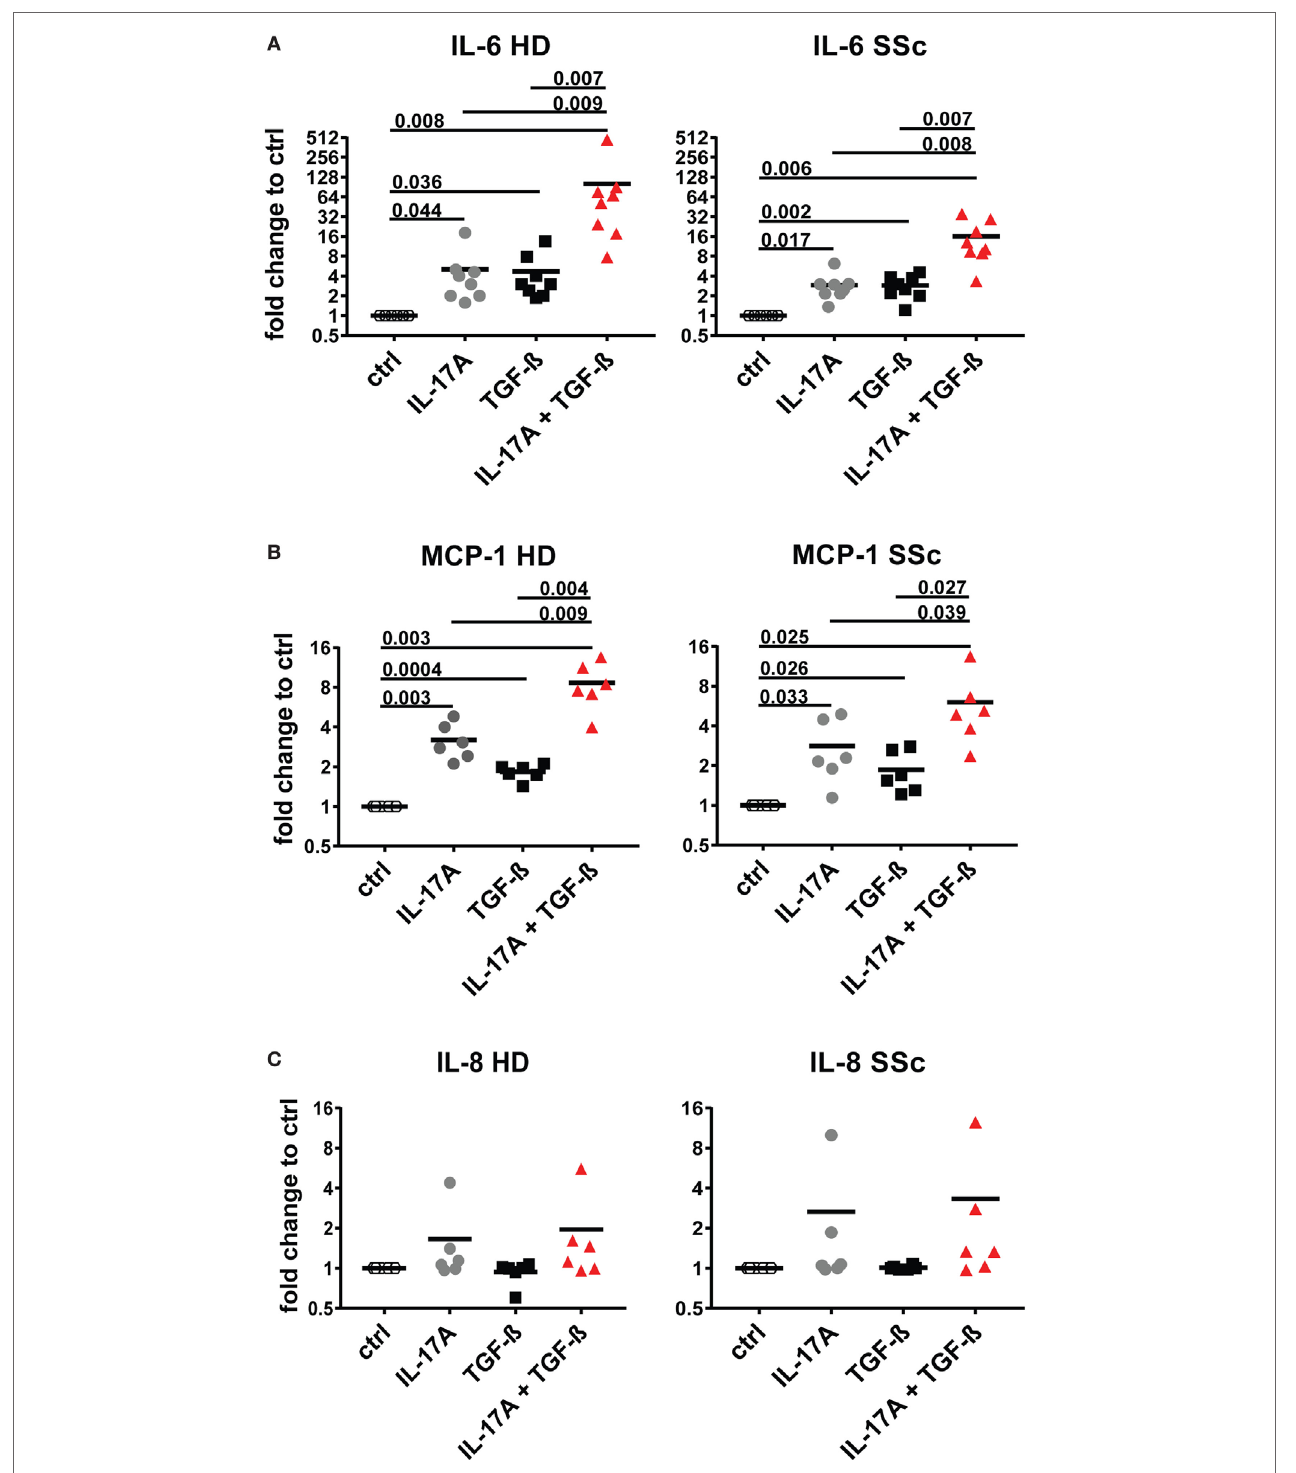
FigUre 1 | IL-6 and monocyte chemotactic protein-1 (MCP-1) are synergistically and specifically induced in human fibroblasts by the combined action of IL-17A and TGF- β . Primary human dermal fibroblasts from healthy donors (HD) and systemic sclerosis (SSc) patients were cultured in the presence of IL-17A (25 ng/ml), TGF- β (2.5 ng/ml), or their combination for 48 h, in 96-well plates, in triplicates. IL-6 (a) , MCP-1 (B) , IL-8 (c) were assessed by ELISA in culture supernatants. Results are expressed as fold change compared to spontaneous production in control (ctrl) cultures. Basal levels were: 22.7 ( ± 7.3) and 40.7 ( ± 16.7) pg/ml for IL-6; 328.1 ( ± 33.3) and 377.2 ( ± 85.4) pg/ml for MCP-1 and 211.8 ( ± 56.6) and 207.7 ( ± 56.9) pg/ml for IL-8, in HD and SSc, respectively. Significance was assessed by paired t test.